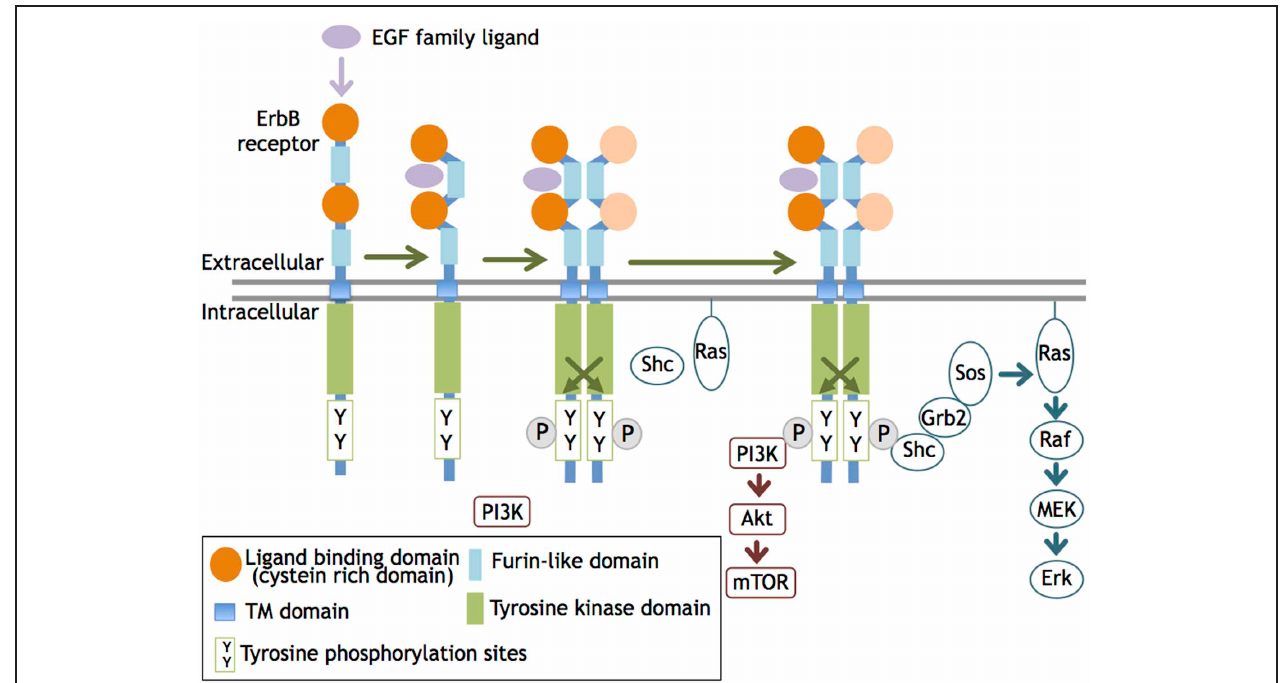
FIGURE 1 | ErbB receptor dimerization and activation. The ligand interaction with ErbB 1, 3, and 4 increases their affinity and induces homo- or heterodimerization of ErbB1-4. This dimerization activates the tyrosine kinase